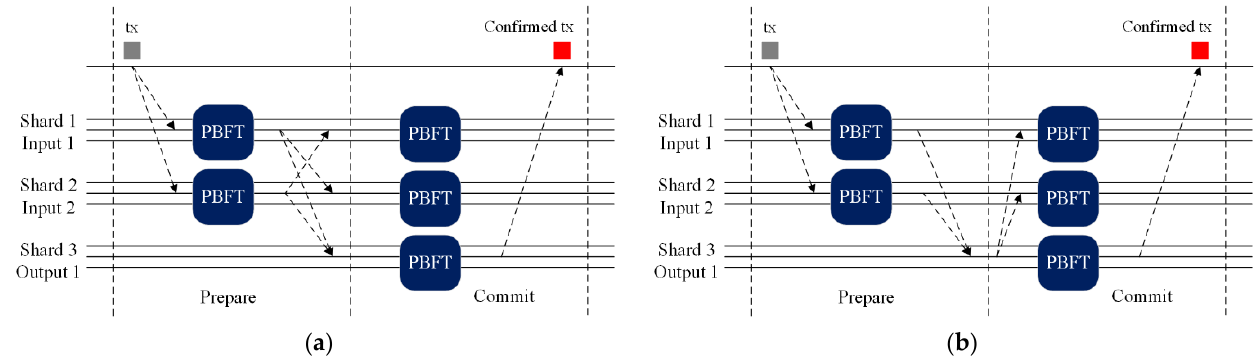
Figure 6. The flowchart of the shard-driven basic 2PC. ( a ) All input shards as the coordinators. ( b ) All output shards as the coordinators.